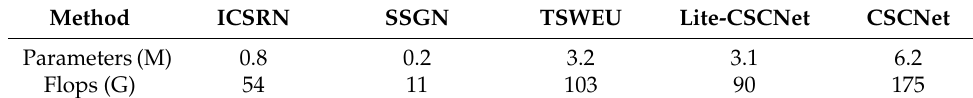
Table 6. Network parameters and flops of five deep learning-based models.